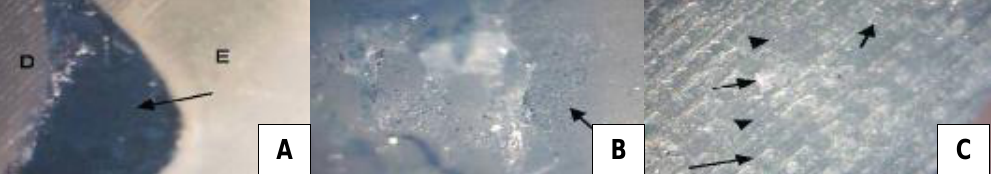
Figure 2: Group A. A.. Photomicrograph view for enamel pretreated with APF shows lesion (arrow) in between enamel (E) and dentine (D). X4 B. Pitted, porous enamel surface (arrow). X4 C.. Other view shows glabular apposition of remineralizing matrix (arrows) with in between a deminerlized dark area (arrows heads). X10